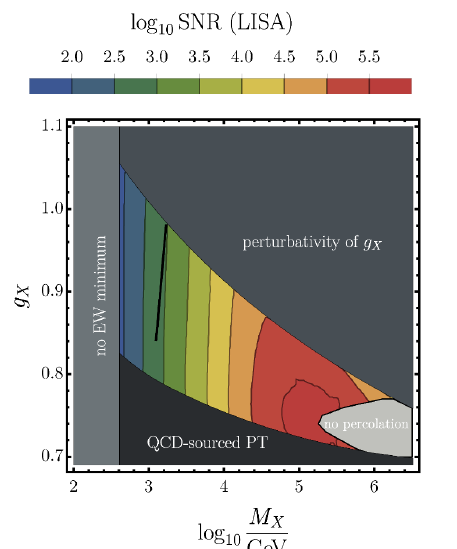
Figure 22 . Predictions for spectra of gravitational waves according to ref. [154] together with integrated sensitivity curves for LISA, AEDGE, ET and LIGO. Left: for a fixed value of g and varying value of M (color-coded). Right: for a fixed value of M X of g (color-coded). X